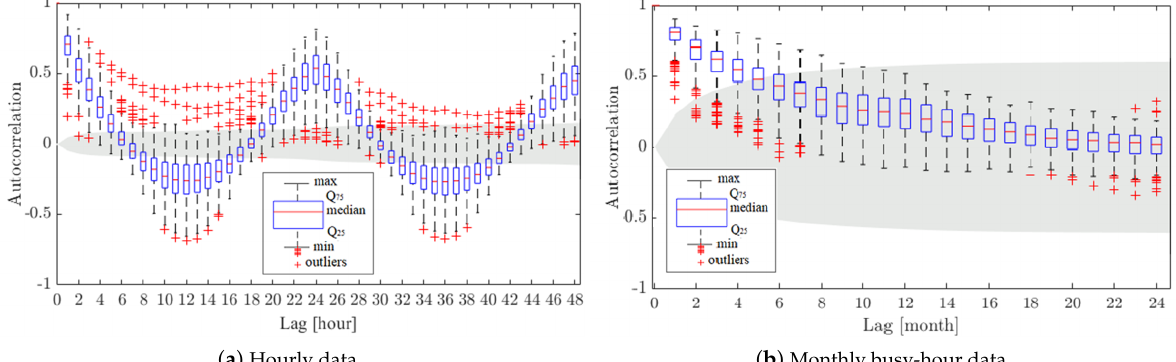
Figure 2. Autocorrelation of cell DL